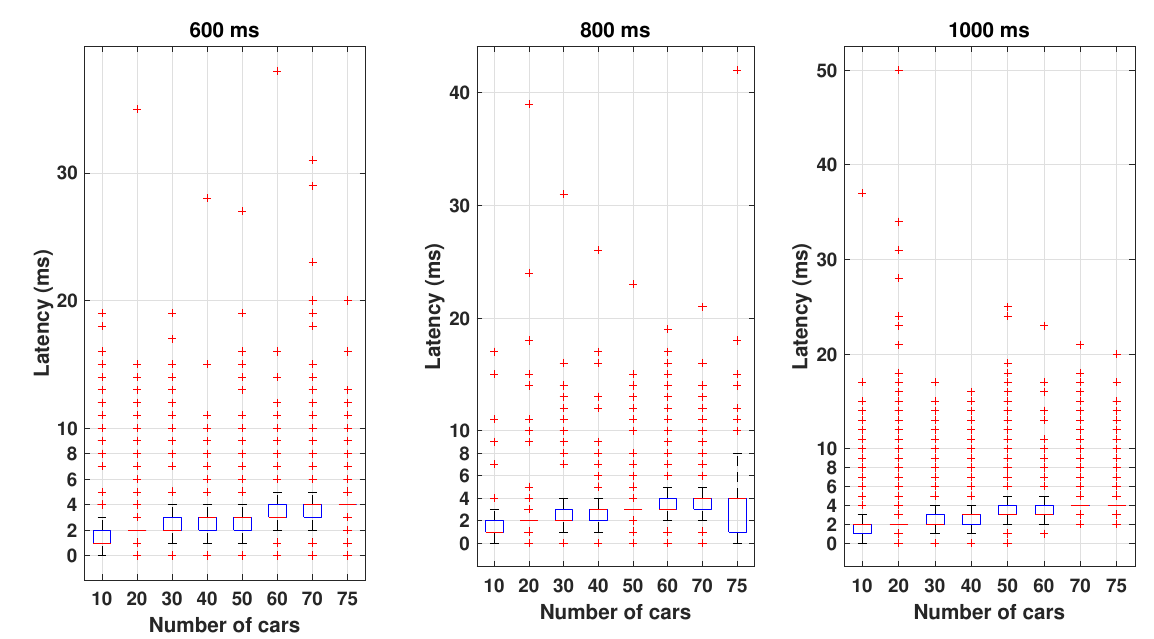
Figure 18. Latency values for 600 ms, 800 ms, and 1000 ms dissemination intervals using ITS-G5